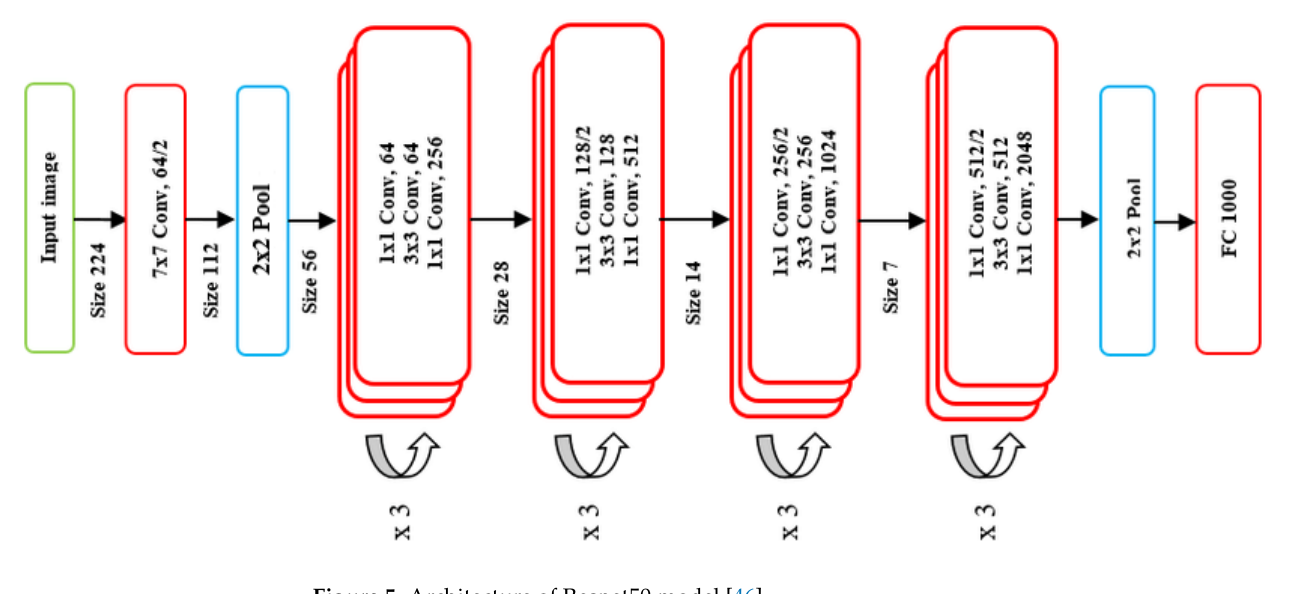
Figure 5. Architecture of Resnet50 model [46]. Table 3. ResNet50